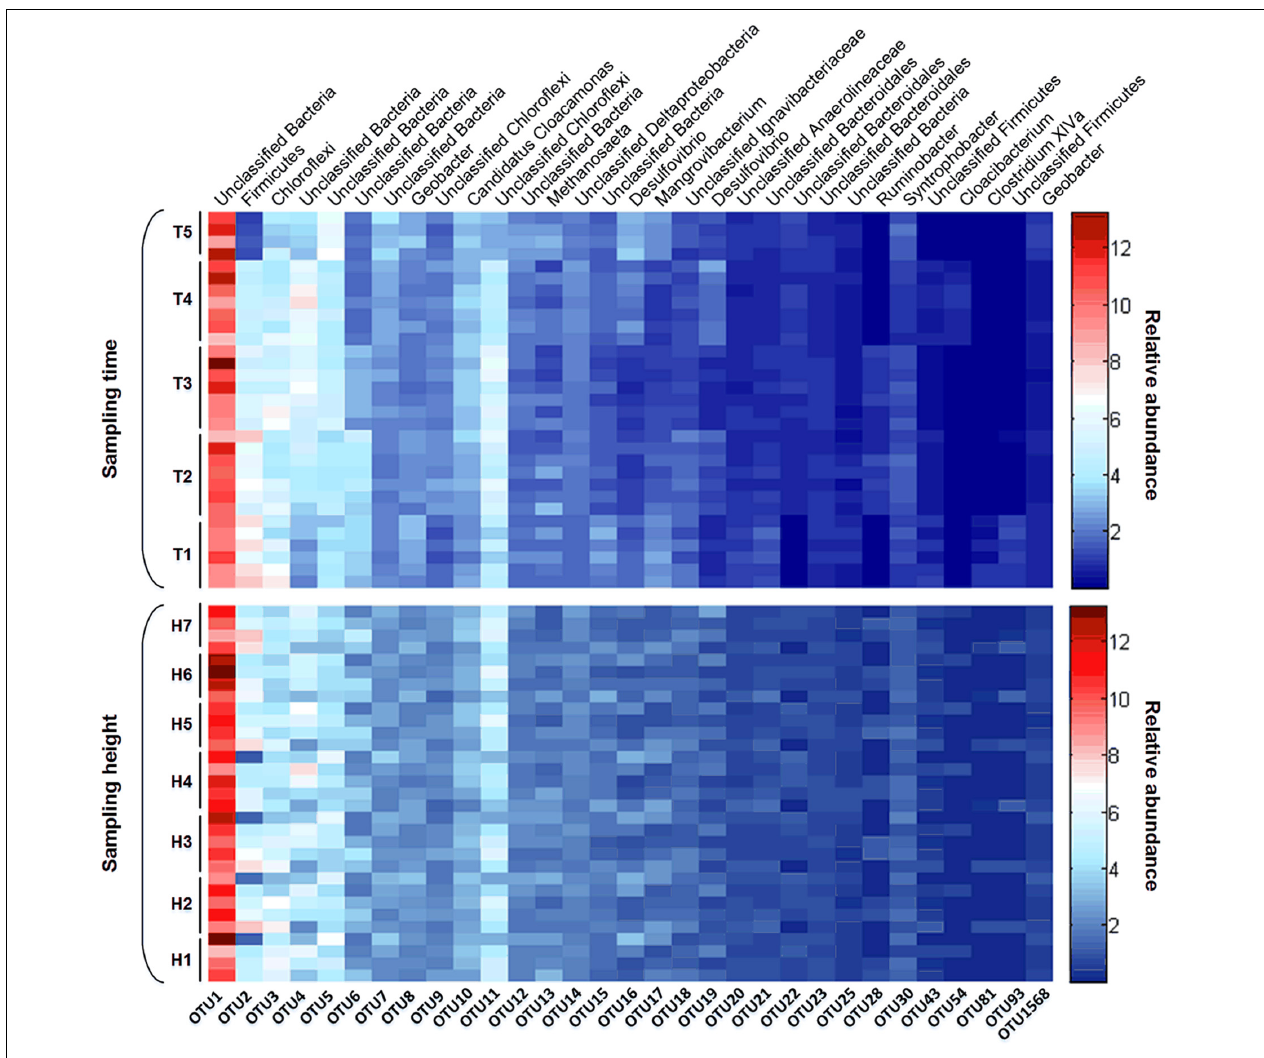
FIGURE 6 | Heatmap of dominant OTUs. The relative abundance and taxonomic information of dominant OTUs in different time points and sampling heights were displayed as upper and below